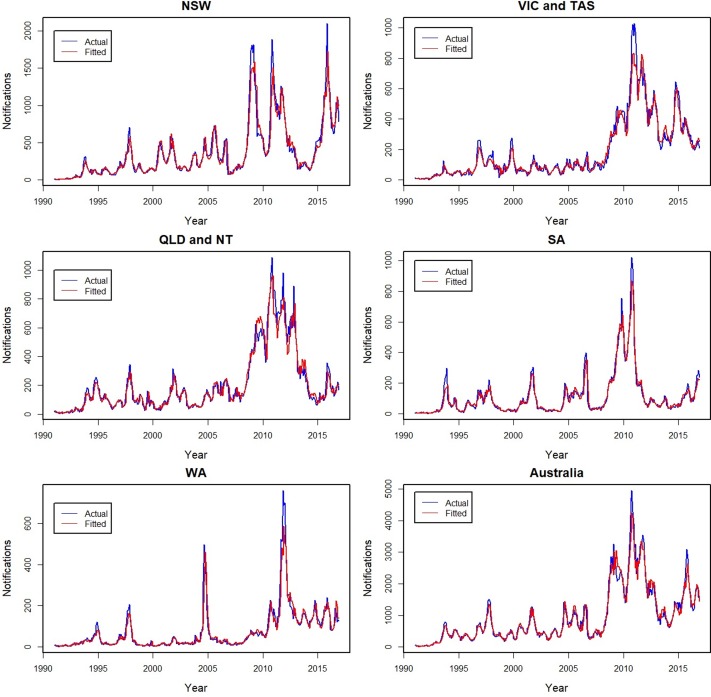
Actual (blue −) and fitted (red −) monthly pertussis notifications from January 1991 to December 2016 by states and territories and for all of Australia (from upper left: New South Wales (NSW), Victoria and Tasmania (VIC and TAS), Queensland and Northern Territory (QLD and NT), South Australia (SA), Western Australia (WA) and Australia).